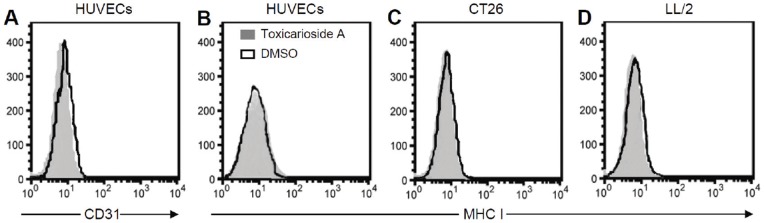
No affect on membrane protein expression. HUVECs, CT26 and LL/2 cells were treated with toxicarioside A (4.5 μg/mL) or DMSO for 24 h.Thereafter, cells were stained with anti-CD31 or anti-MHC I and analyzed by flow cytometry. Shown are representative histograms of cells treated with toxicarioside A (gray) and DMSO (solid black line).